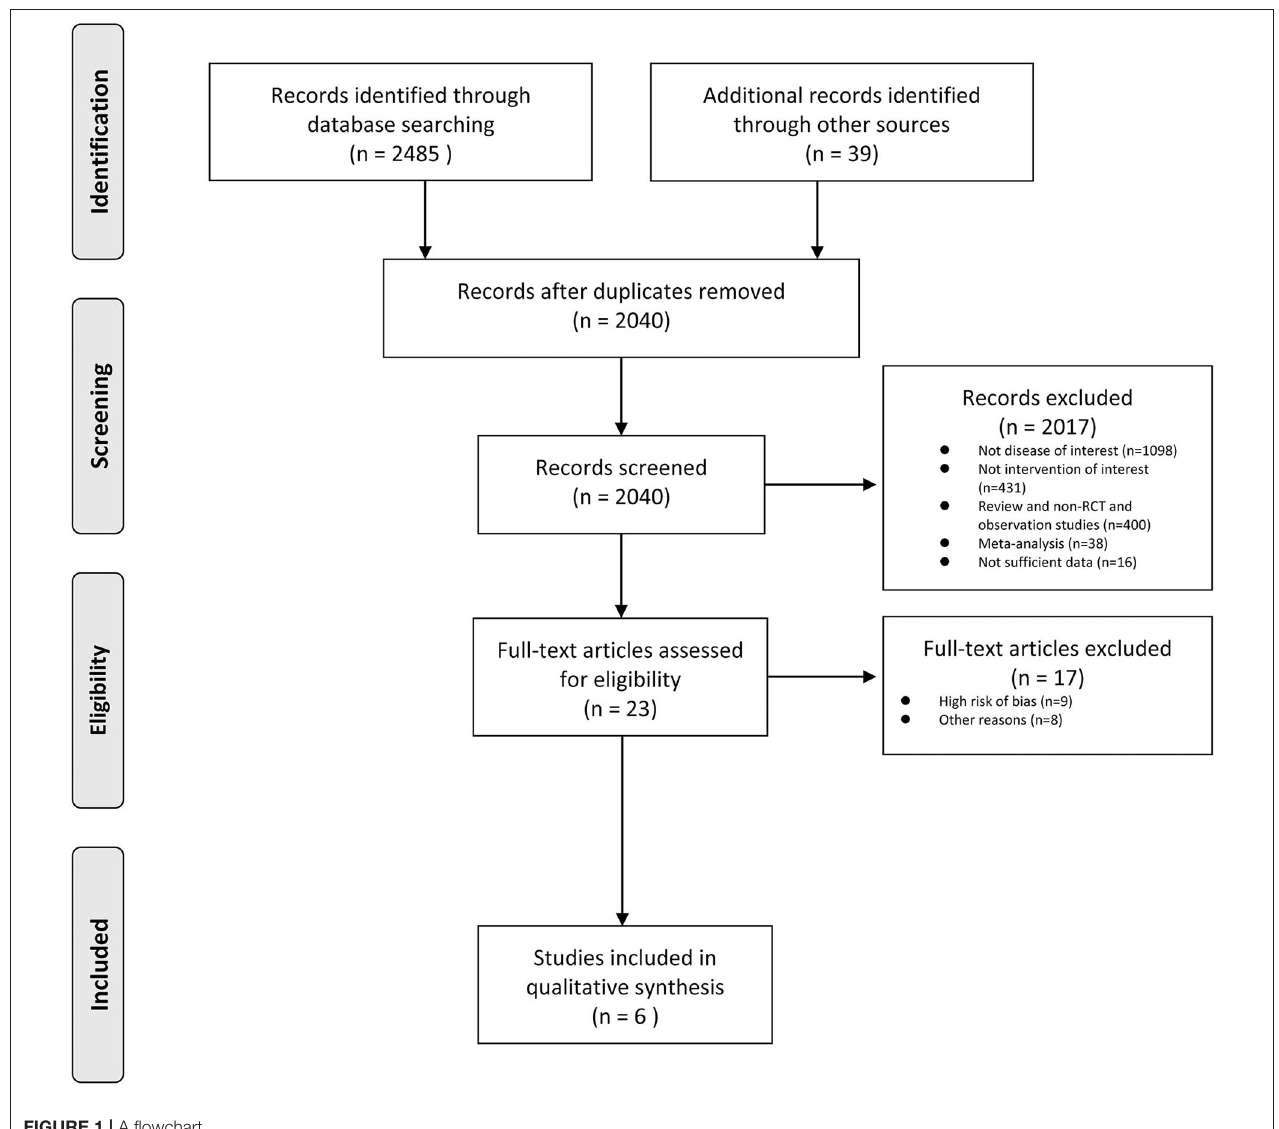
FIGURE 1 | A flowchart.